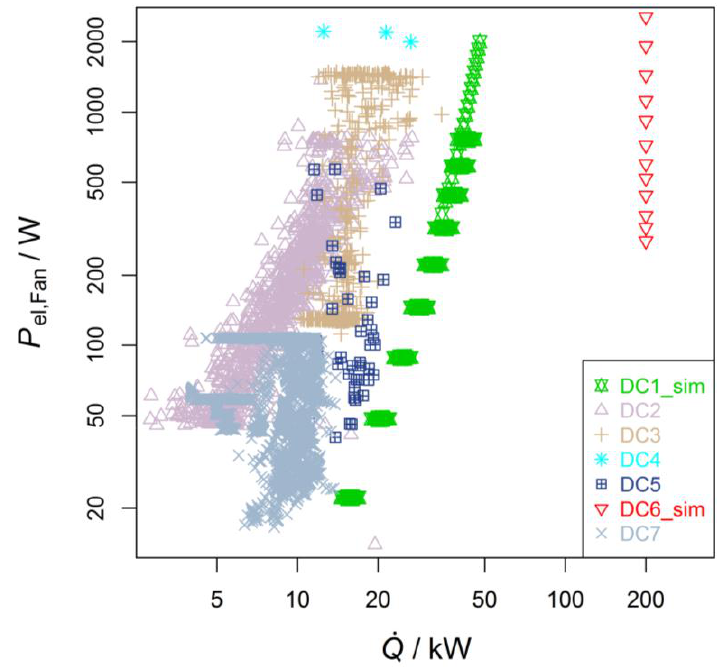
Figure 5. Electric power for fans ( 𝑃 ) versus rejected heat ( 𝑄̇ ) for simulated and el,Fan monitored dry coolers (in boundary B1). This depiction is not suitable to compare performance of HRU.